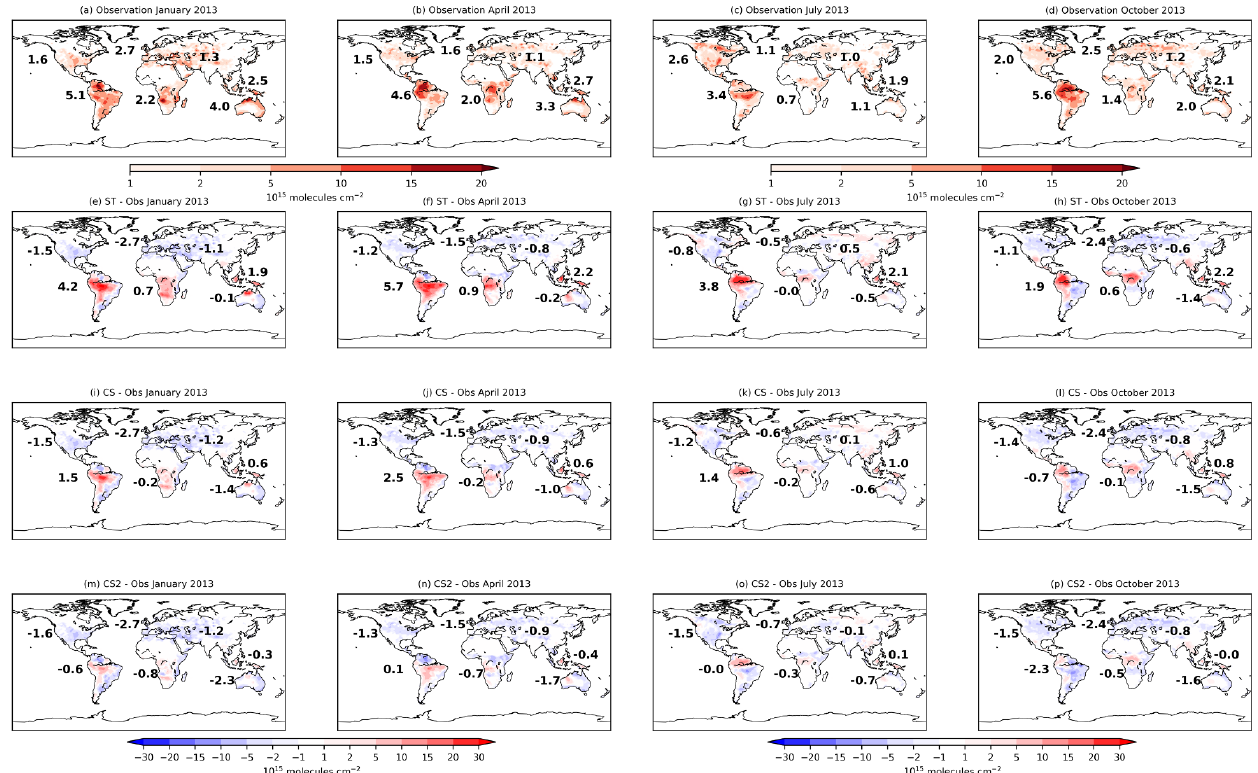
Figure 3. Monthly mean isoprene column values from the global isoprene column observational data set (Wells et al., 2020) for (a) January, (b) April, (c) July, and (d) October 2013. Model bias (model–observation) using (d–h) ST, (i–l) CS, and (m–p) CS2. Numbers in (a–d) show the area-weighted mean model column values and in (e–p) show the model bias for individual terrestrial regions (the number in the North Atlantic refers to Europe and that in the South Atlantic refers to